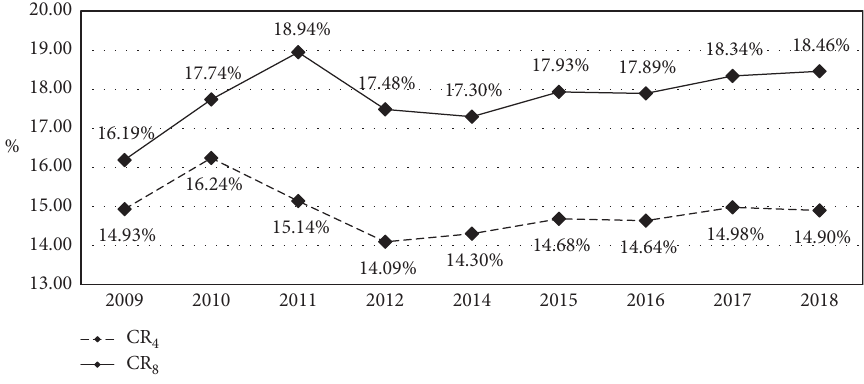
Figure 1: CR n from 2008 to 2018 in China’s